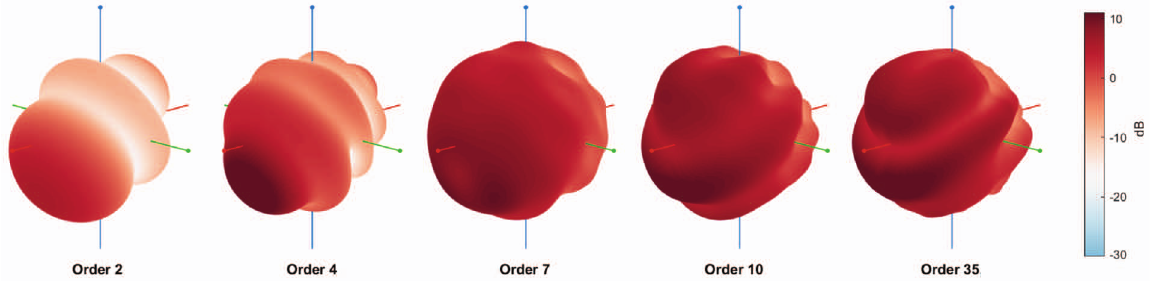
Figure 1. 3D view of directivity patterns from measurements of the arti fi cial speaker at 3 kHz for truncation at various spherical harmonics orders.